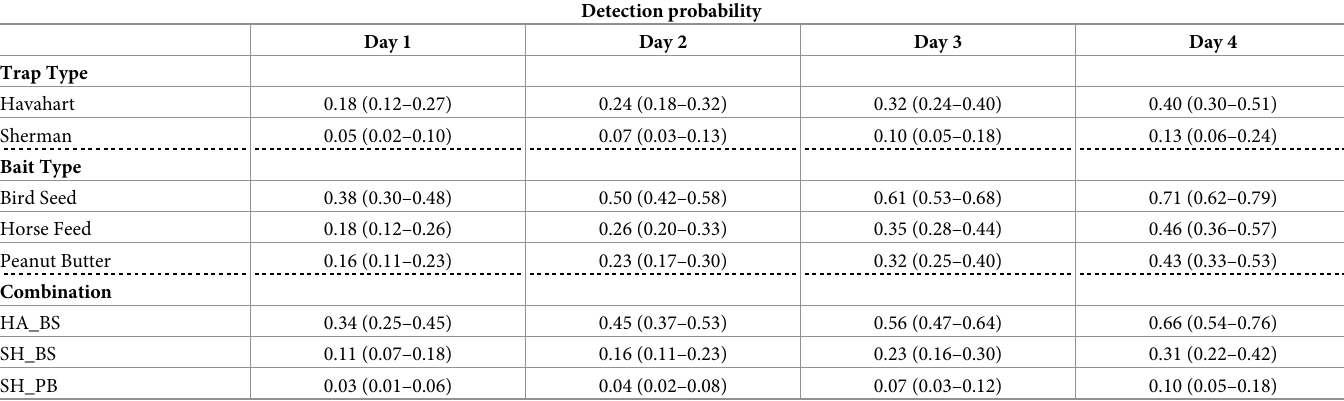
Table 3. Estimates of detection probability and na ï ve occupancy for olive-back pocket mice from the best fitting (temporal) model assessing the effects of different trap and bait